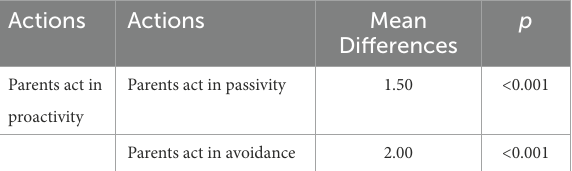
TABLE 9 Mean differences of three level of actions Bonferroni pairwise comparison ( n =